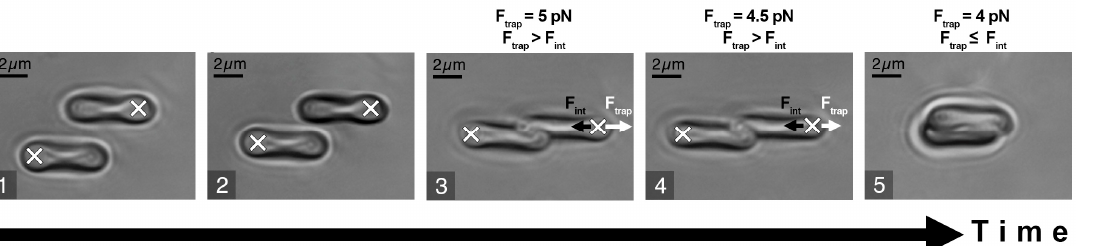
Figure 2. Schematic representation of RBC interaction force (F int ) measurement procedure: white crosses describe the positions of the optical traps: white arrows point at the direction of the trapping force (F trap ); short black arrows point at the direction of F int . (1) Two cells are trapped and orientated in parallel; (2) cells are brought into contact, forming a doublet; (3) attempt to separate the cells by moving the laser trap and (4) simultaneously decreasing laser power to measure the minimal trapping force required to separate the cells; (5) below the minimal trapping force, the cell escapes the trap and overlaps the other one. The obtained minimal trapping force is assumed to be equal to the RBC interaction force.